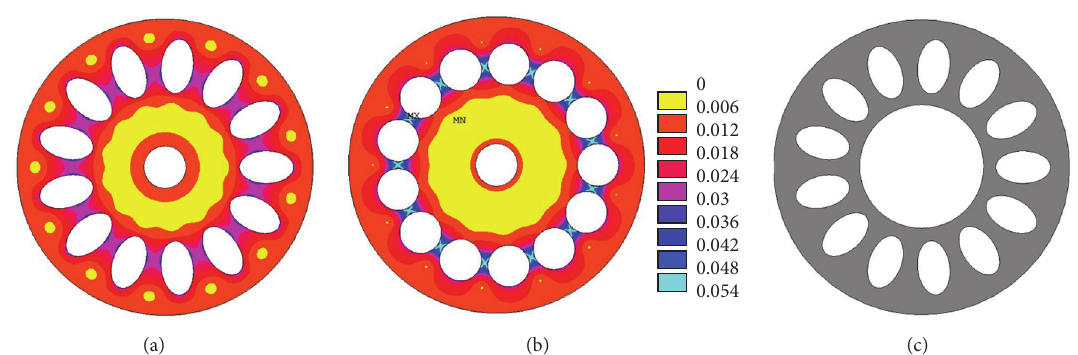
Figure 11: (a) The von Mises stress (MPa) in a section with oval holes, (b) von Mises stress in a section with circular holes, and (c) a proposed pipe cross